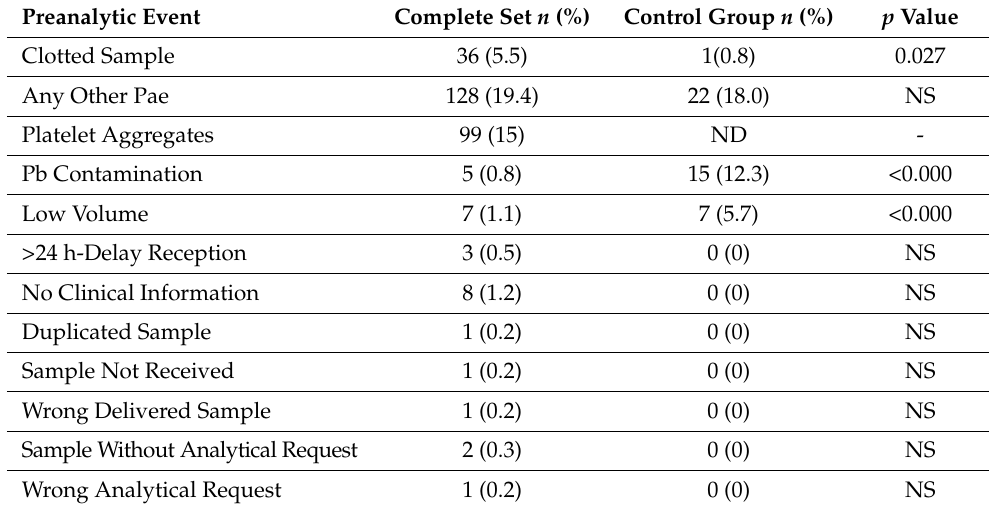
Table 3. Preanalytical